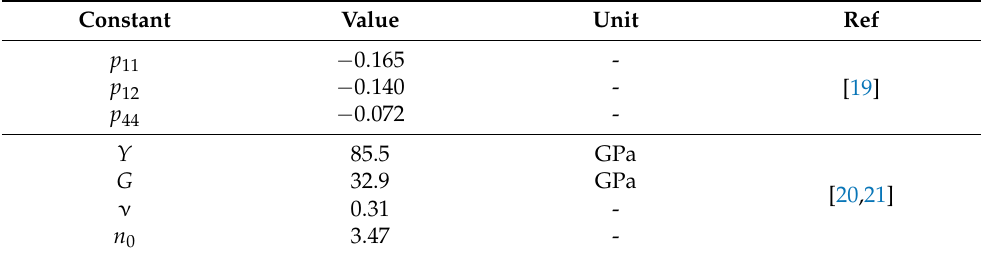
Table 1. Opto-mechanical properties of